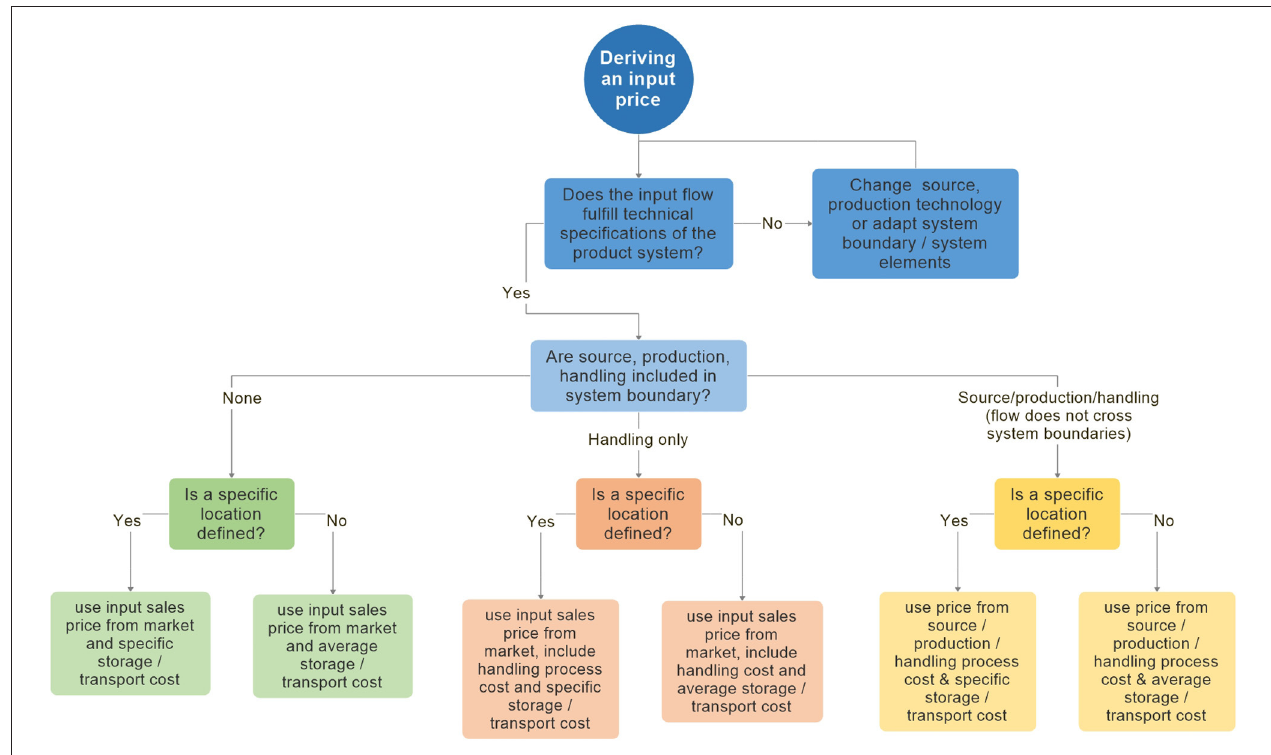
FIGURE 6 | Deriving an input